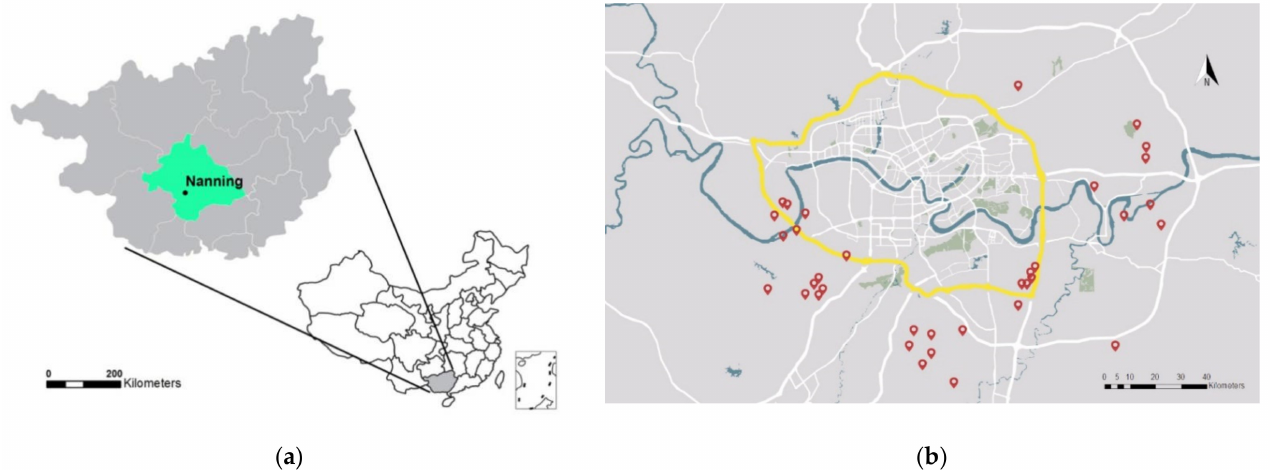
Figure 1. The research area in southern China: ( a ) The position of Nanning in Guangxi Zhuang Autonomous Region; ( b ) sampled villages position (red flags) around the first highway that circles the city (yellow line). Most villages were distributed to the east, west and south of the city. Panel ( a ) was downloaded from www.d-maps.com (accessed on 1 September 2020) and modified in Adobe Photoshop by C. Li. Panel ( b ) was downloaded from www.guihuayun.com (accessed on 1 September 2020) and also modified in Photoshop by C.